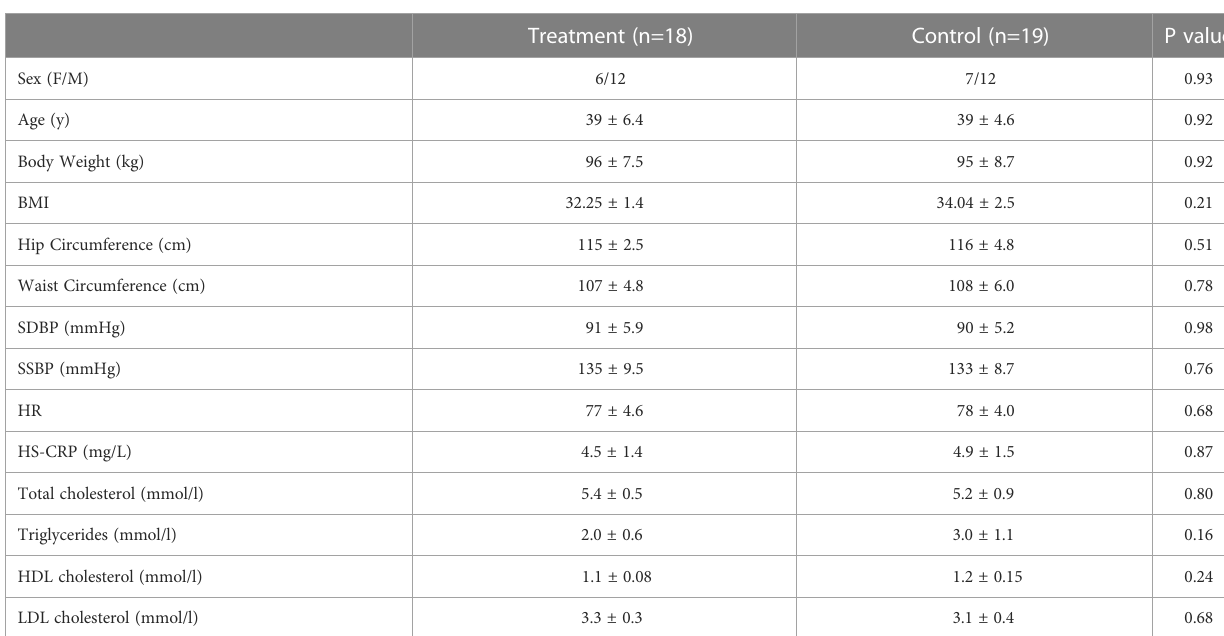
TABLE 1 Baseline